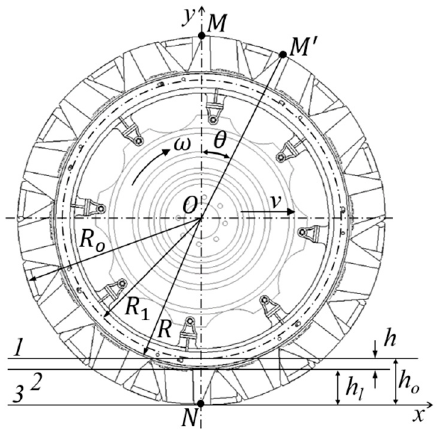
Figure 5. The rolling condition diagram of the rigid lugged